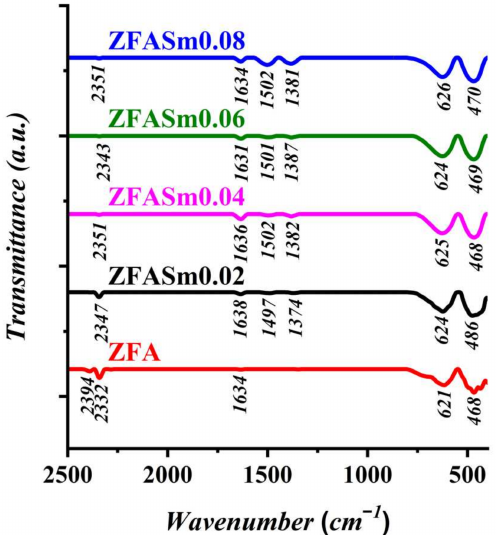
Figure 2. FTIR spectra of ZnAlFe 1 − x Sm x O 4 (x = 0, 0.02, 0.04, 0.06, 0.08)